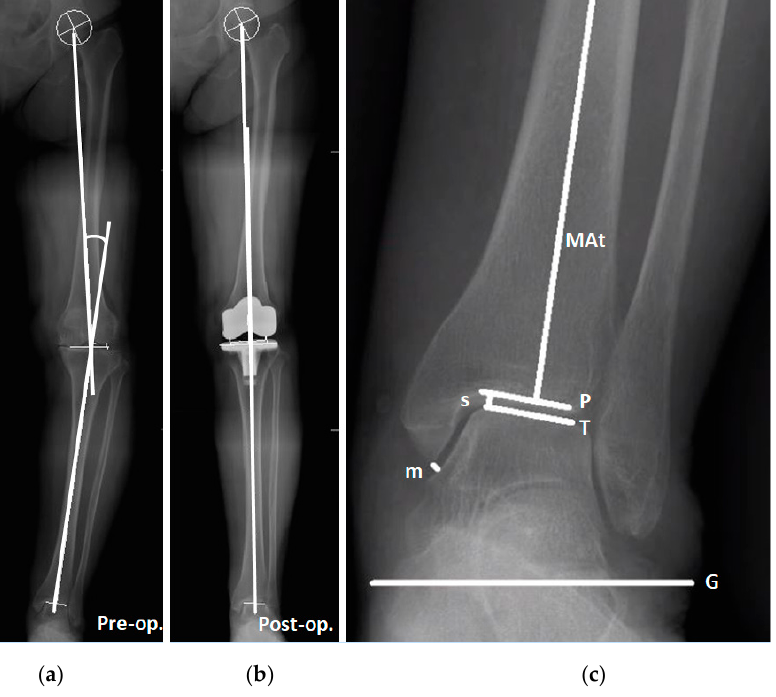
Figure 1. Preoperative and postoperative measurement of radiographic parameters for the knee and ankle in one patient. ( a ) Preoperative HKA measurement. Positive HKAs denote varus knee alignment, whereas negative HKAs denote valgus knee alignment. ( b ) Postoperative HKA measurement. ( c ) Ankle parameters: MAt line, mechanical axis of the tibia; P line, tibial plafond; T line, talar dome; G line, ground line. The LDTA is defined as the lateral angle of the MAt line and the P line. The PGA is defined as the angle between the P line and the G line. The TGA is defined as the angle between the T line and the G line. The PTA is defined as the angle between the P line and the T line. Positive PGA, TGA, and PTA values mean that the angle opens outward, whereas negative values mean that the angle opens inward. The MS and SS are indicated by m and s, respectively.